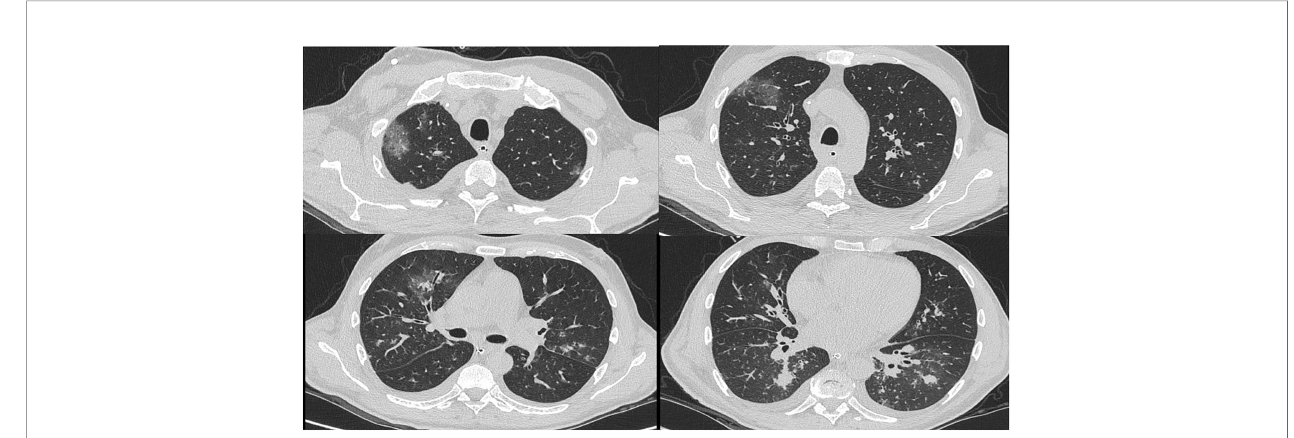
FIGURE 1 | Patient 1# CT